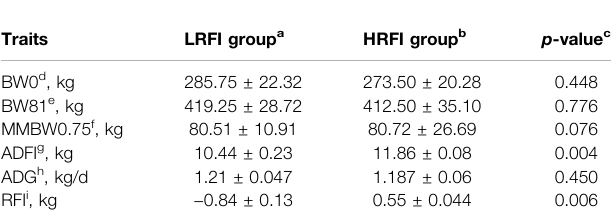
TABLE 1 | Analysis of differences for growth traits between the HRFI and LRFI groups (Mean ± Sd)